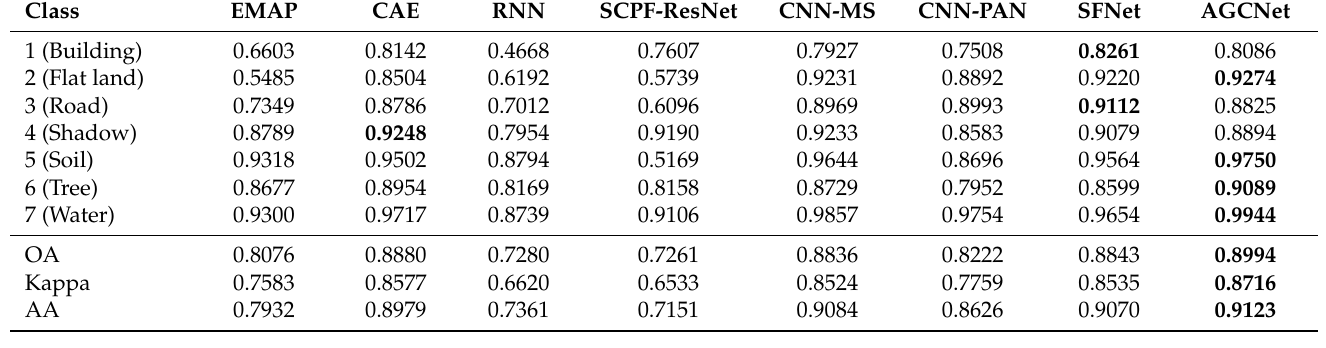
Table 5. Classification accuracy on Xi’an Urban dataset.